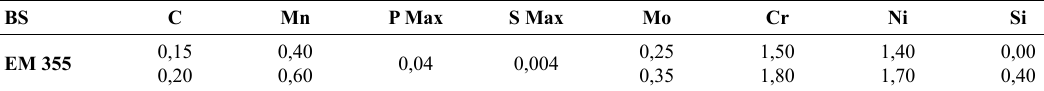
Table 1. Nominal chemical composition in wt % for AISI 4317